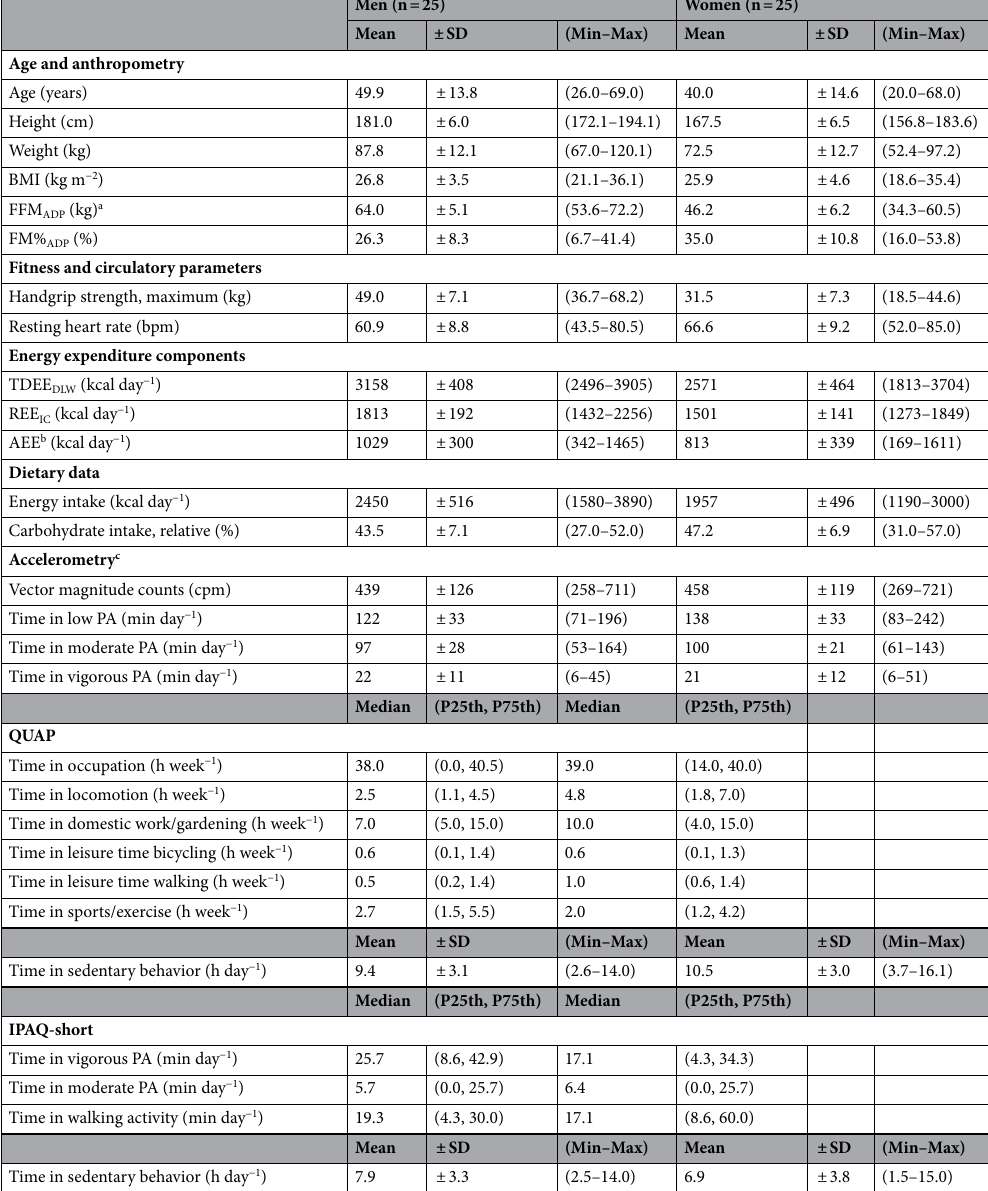
Table 1. Main characteristics of ActivE study population stratified by sex. Data are presented as mean, standard deviation (SD), minimum (Min) and maximum (Max), or as median, 25th and 75th percentile (P25th, P75th) separately for men and women. Additional characteristics are provided in Supplemental Digital Content Table 4. a Similar results were obtained with the BIA method (see Supplemental Digital Content Table 4, which shows additional characteristics of ActivE study population stratified by sex). b AEE